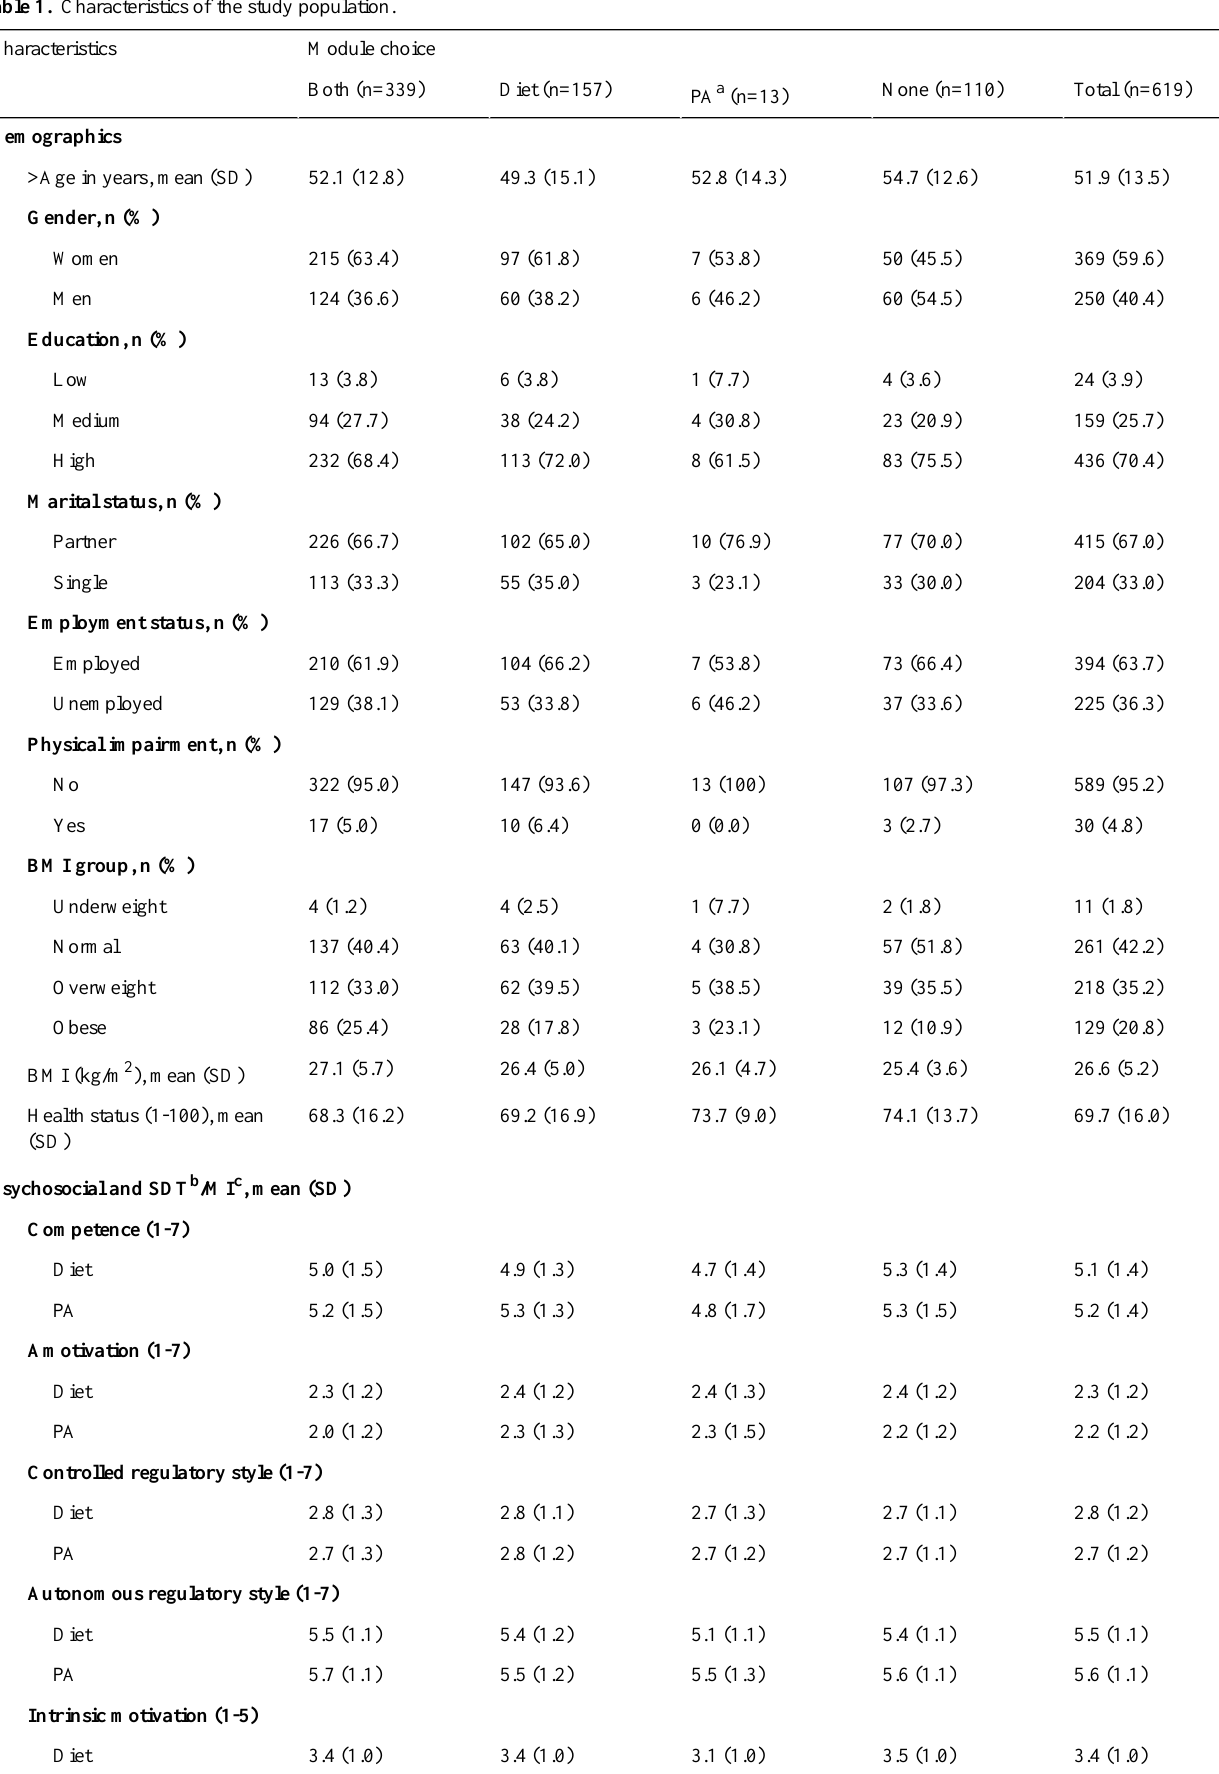
Table 1. Characteristics of the study population.